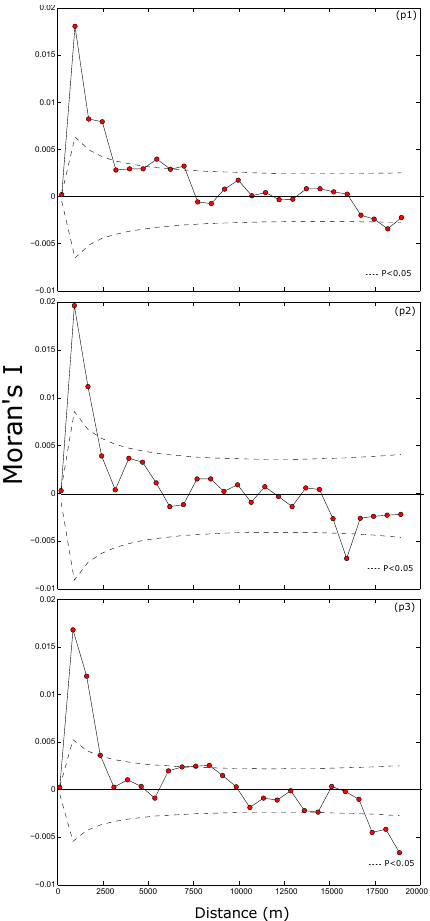
Figure 3. Moran’s correlograms of canopy height for plots p1, p2, and p3 in the Regina forest, French Guiana. Moran’s correlograms indicate a significant effect ( p -value < 0.05) of spatial autocorrelation up to 2500